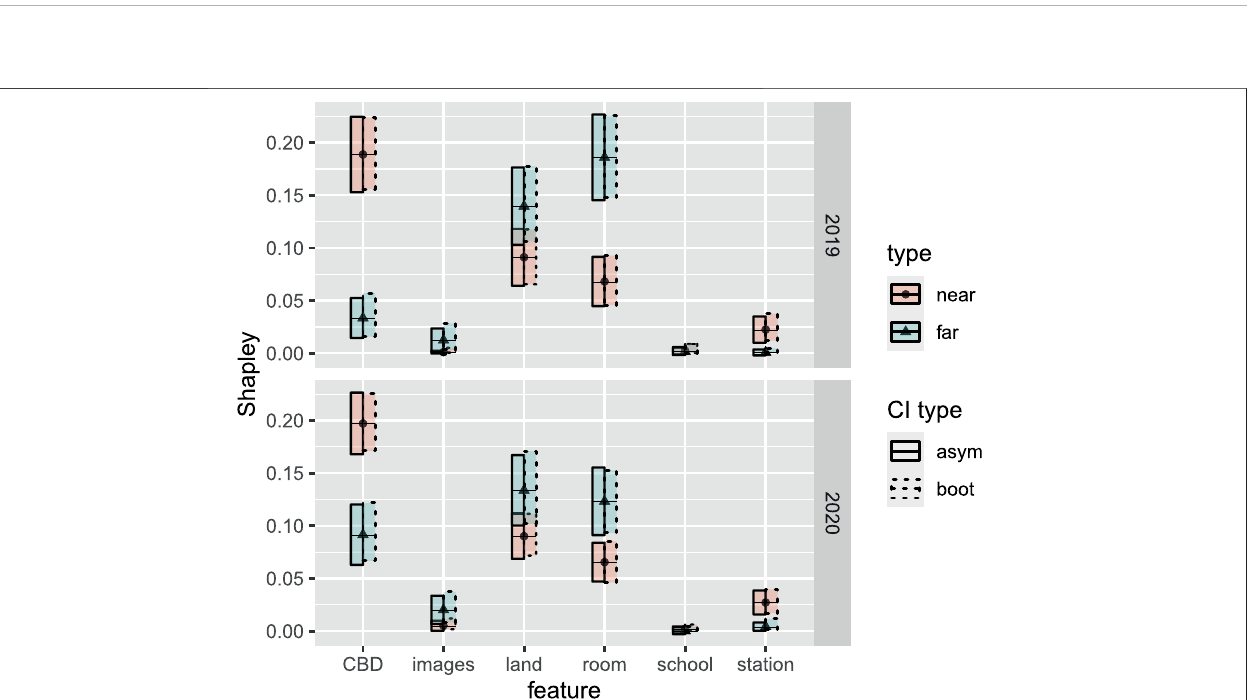
FIGURE 11 | Shapley values and associated asymptotic 95% con fi dence intervals (labelled as CI type “ asym ” ) for each of the six covariates, within the four real estate data subgroups (near/far and 2019/2020). Blue bands and triangle markers represent the near subgroup (i.e., ≤ 25km from Central Business District) and red bands withcircularmarkersrepresentthefarsubgroup ( > 25km ) .Beside theasymptoticCIs,thecorresponding bootstrapCIs areshownwithdashed lines (labeledas CI type “ boot ” ).